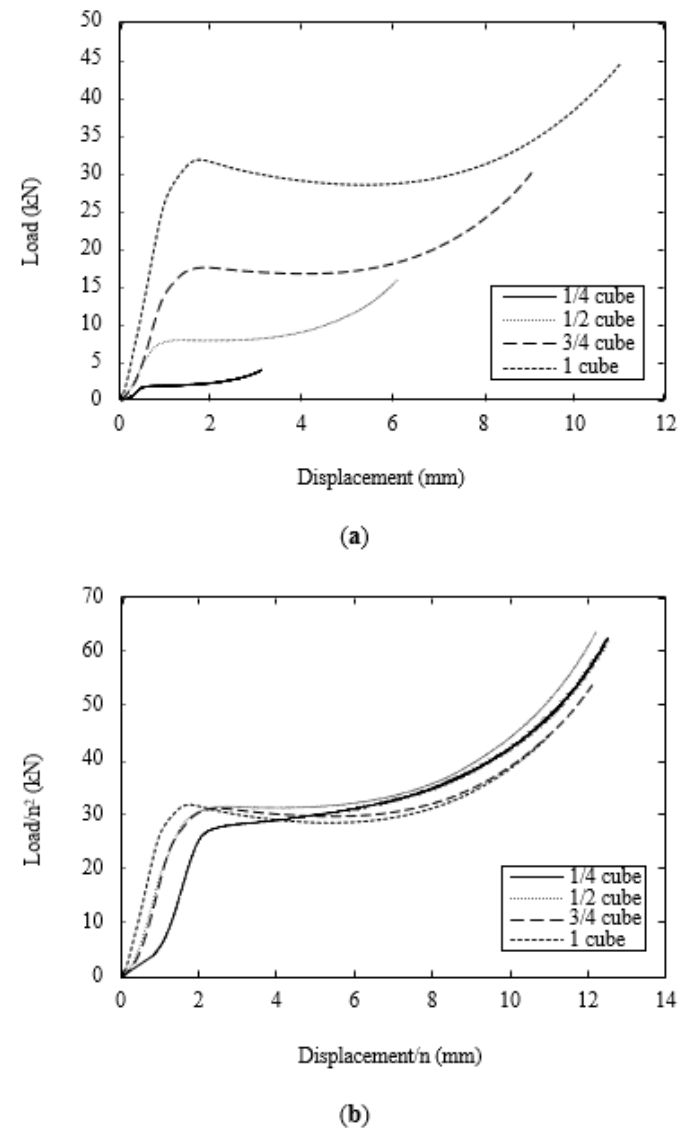
Figure 5. ( a ) Typical load–displacements traces following compression tests on the cubes. ( b ) Typical scaled load – displacements traces following compression tests on the cubes.